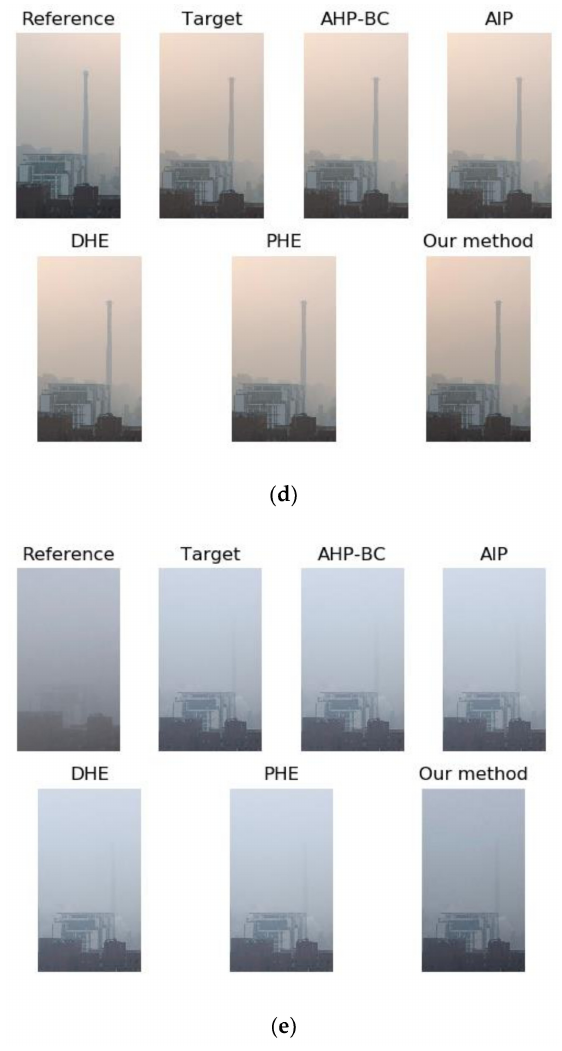
Figure 12. Comparison of different brightness correction methods. ( a ) is the comparison of different algorithms when the level is excellent; ( b ) is the comparison of different algorithms when the level is good; ( c ) is the comparison of different algorithms when the level is light; ( d ) is the comparison of different algorithms when the level is moderate; ( e ) is the comparison of different algorithms when the level is